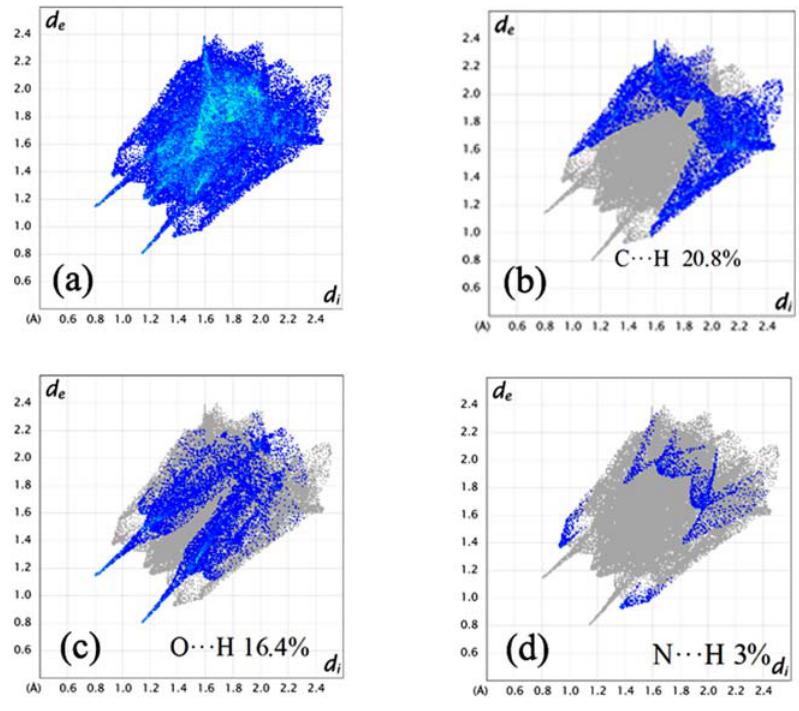
Fig. 9. 2D Finger print plot of experimental Form II with a) 100% contribution of all elements b) 20.8% of C···H/H···C interaction c) 16.4% O···H/H···O interaction d) 3% of N···H/H···N interaction.